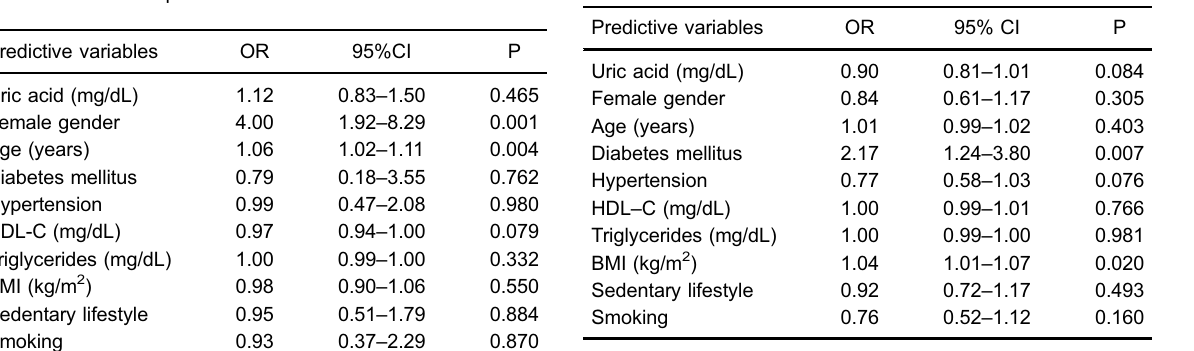
Table 3. Multivariate logistic regression model for predictors of fast progression along the follow-up.